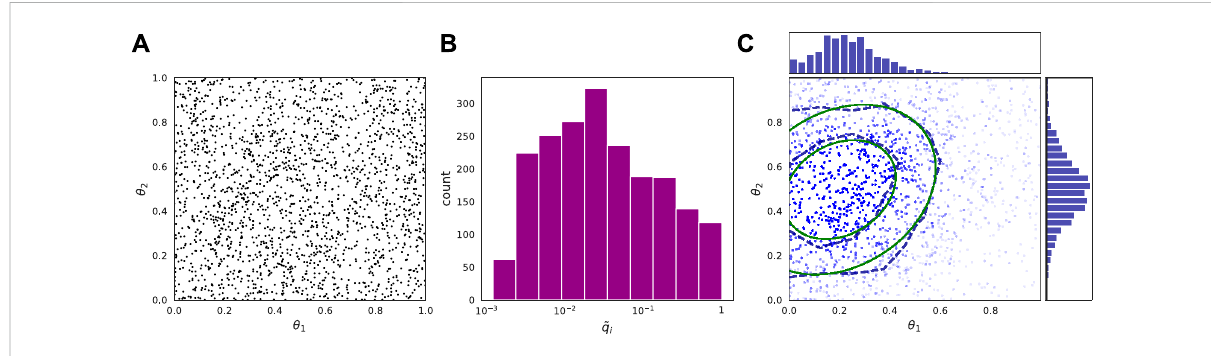
FIGURE 1 IllustrationofS/IRprocedures. (A) Samples { θ } n i (cid:2) 1 fromtheuniformpriorinaunitsquare( n =2000samplesareshown). (B) Histogramofrescaled importance weights ~ q i (cid:2) q i /max ({ q }) where q i (cid:2) L ( θ i ) / (cid:4) n j (cid:2) 1 L ( θ j ) with L ( θ ) as in Eq. 6. The number of effective samples is n eff = 214.6. Note that the samplesaredrawn fromaunitsquare andthatthetailofthetarget distribution isnot covered. (C) Samples { θ * } N i (cid:2) 1 oftheposterior(blue dotswith10% opacity) resampled from the prior samples with probability mass q i . The contour lines for the 68% and 90% credible regions of the posterior samples (blue dashed) are shown and compared with those of the exact bivariate target distribution (green solid). Summary histograms of the marginal distributions for θ 1 and θ 2 are shown in the top and right subplots.